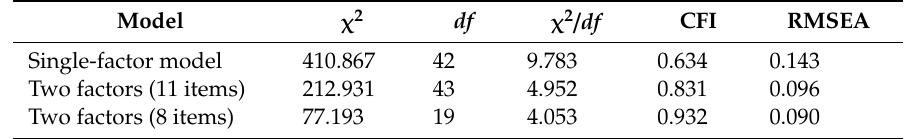
Table 5. Competing CFA Models for Procrastination